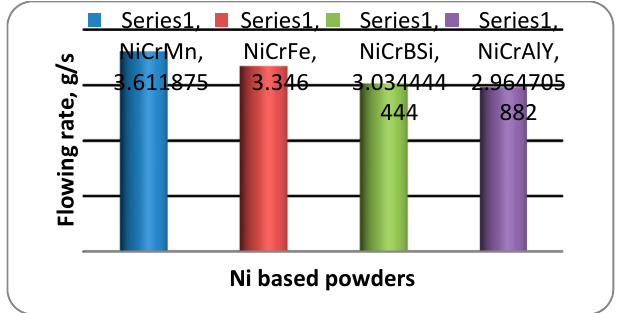
Figure 3. Comparative flow rate determination for Ni based powders, under atmospheric